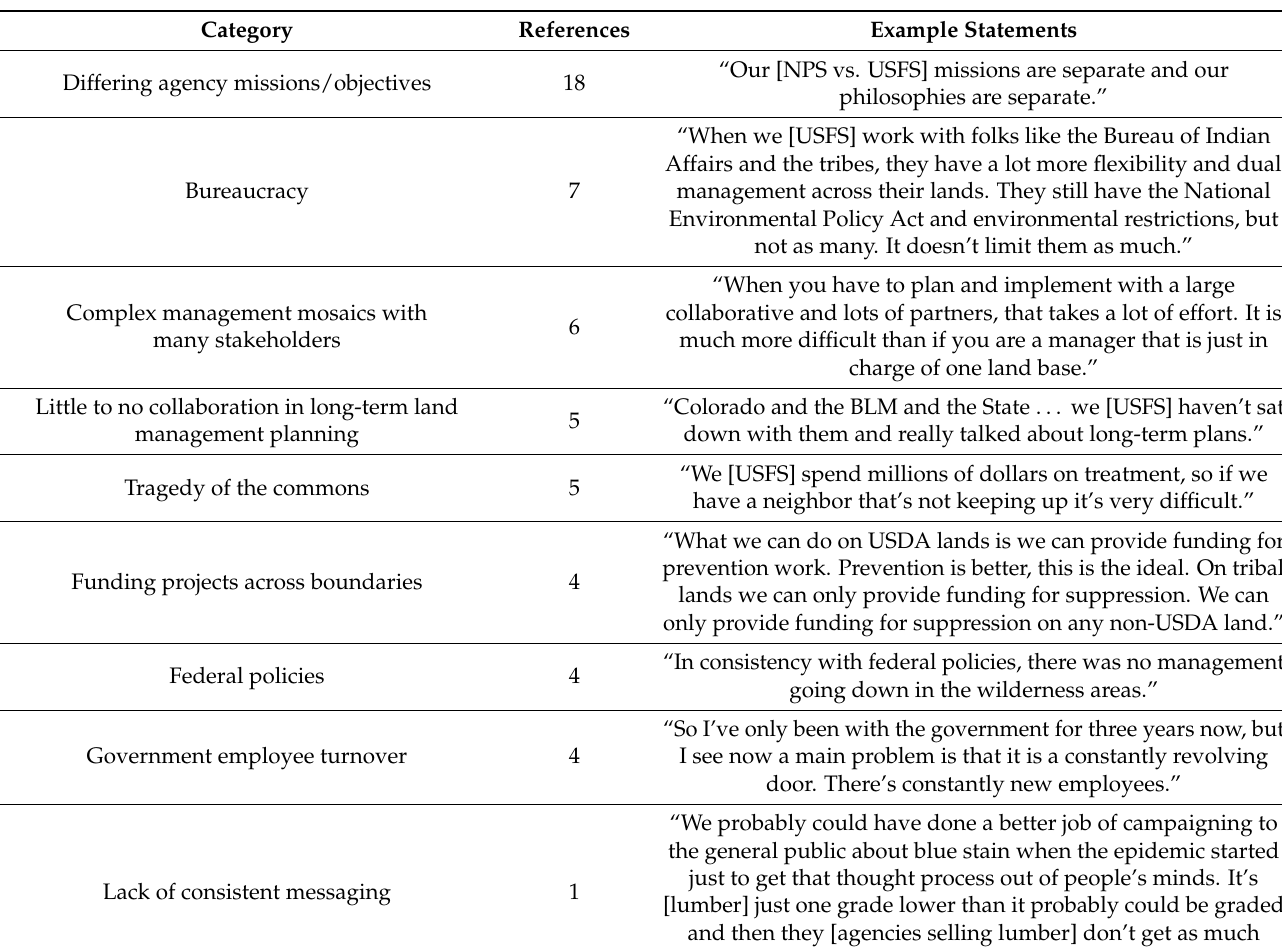
Table 2. Challenges associated with cross-boundary forest pest outbreaks identified across interview respondents, with example quotes illustrating each challenge. “References” refers to the number of unique mentions of each